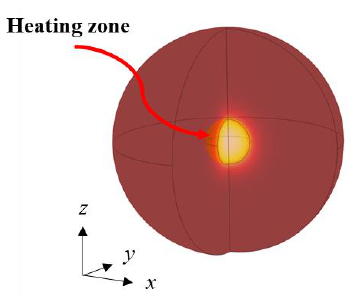
Figure 1. Geometry of the physical domain.